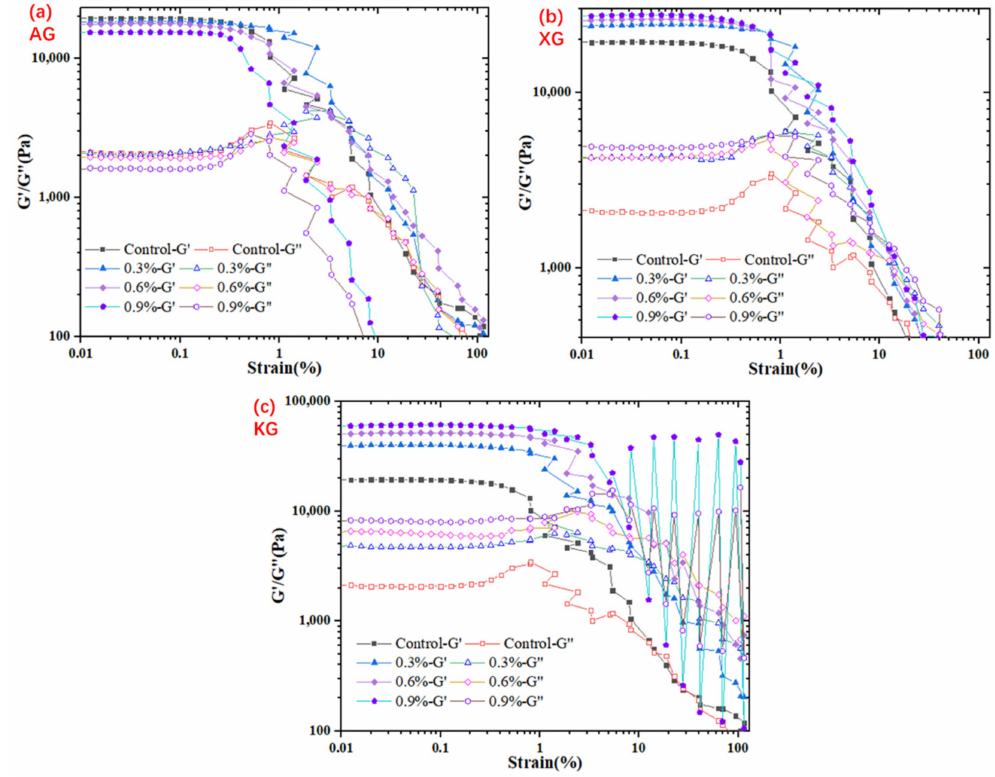
Figure 3. Strain-dependence of viscoelasticity of ink samples with different formulation. ( a ): AG; ( b ): XG; ( c ): KG.